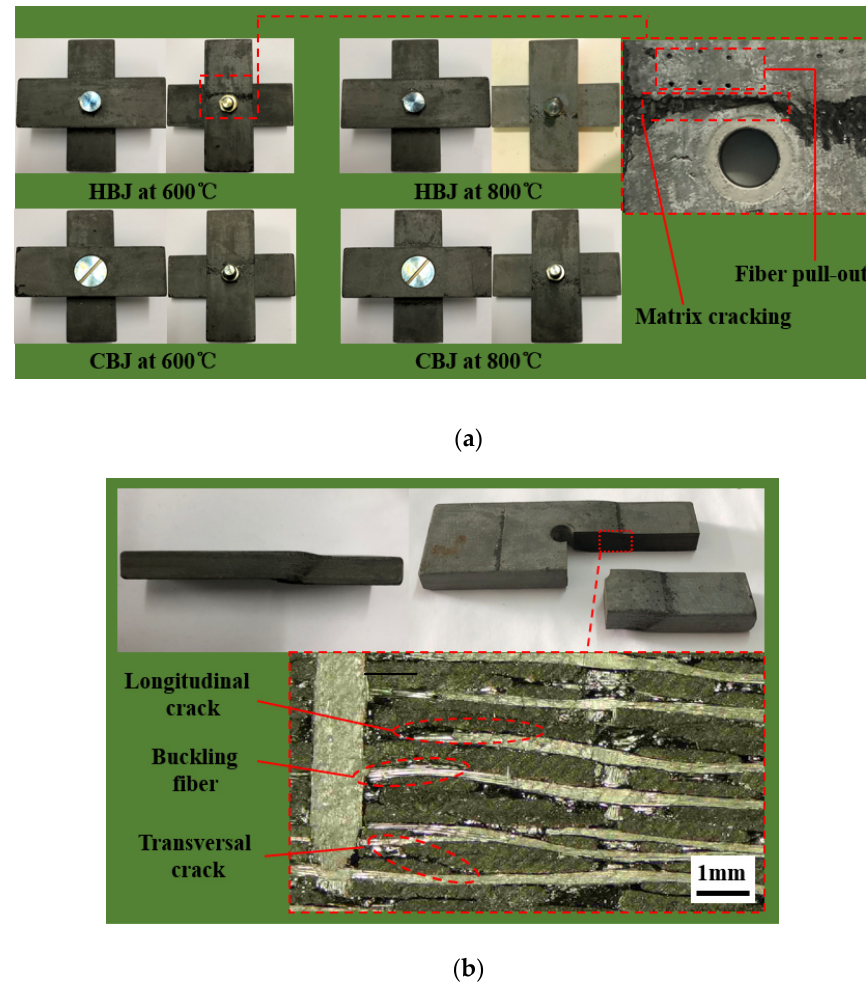
Figure 8. Failure morphology of the ( a ) top and bottom surfaces and the ( b ) side of the lower lap plate.